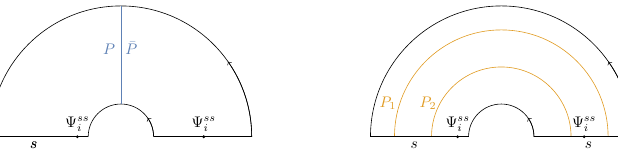
Figure 11 . Different illustration of the “boundary necklace” and “boundary bagel” decompositions of the cylinder two-point function with operators on each boundary (see figure 5 in section